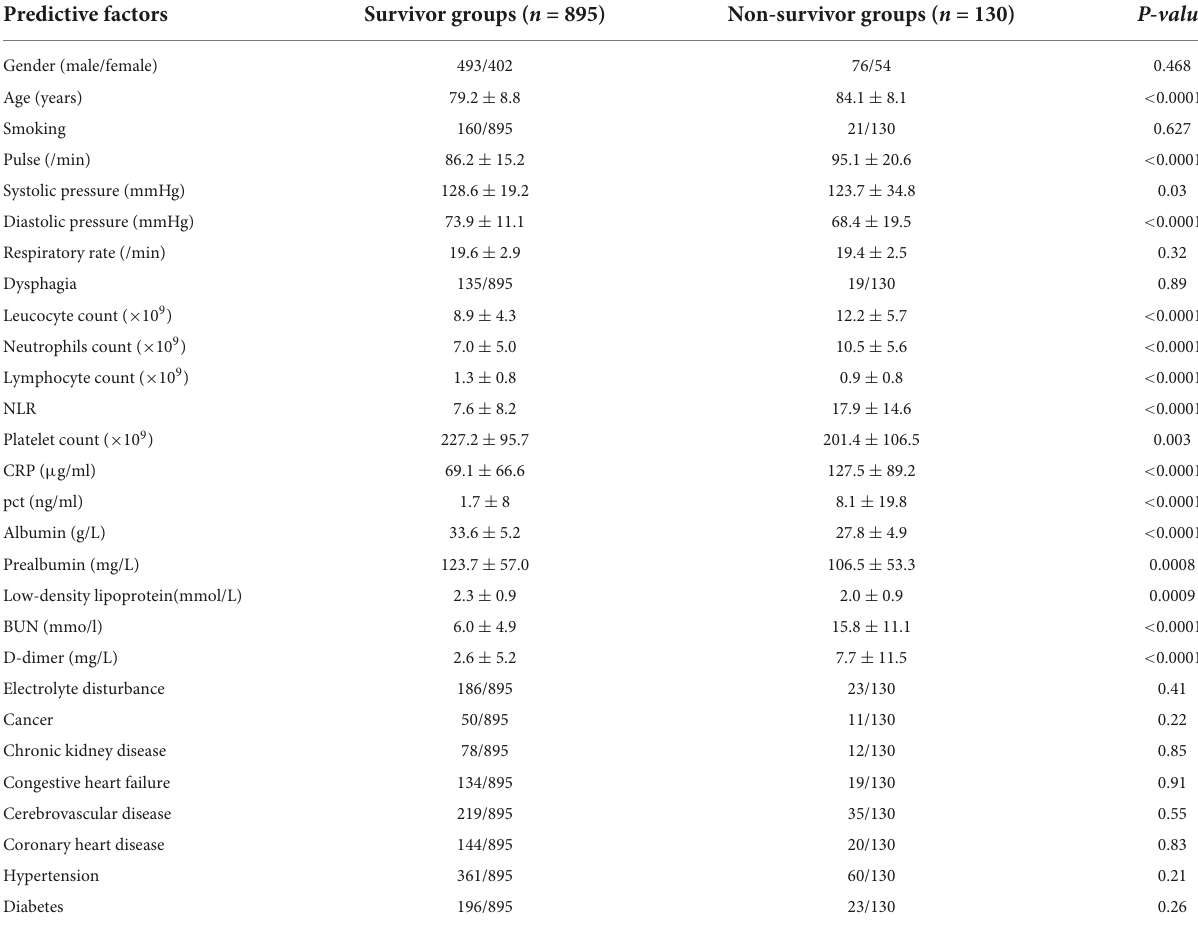
TABLE 1 Basic characteristics of survival and death